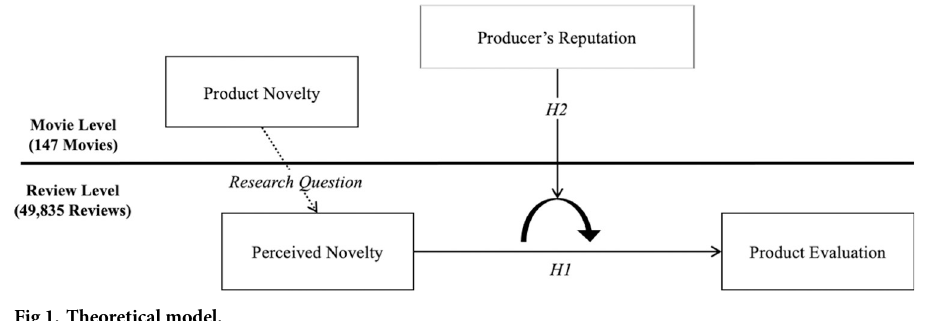
Fig 1. Theoretical